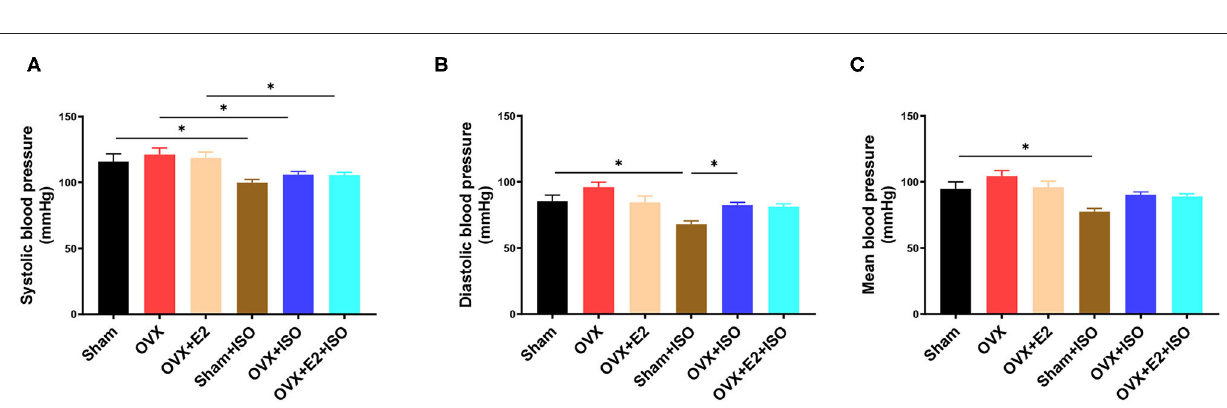
FIGURE 2 | Estrogen decreases blood pressure during catecholamine stress. (A) The systolic blood pressure. (B) The diastolic blood pressure. (C) The mean blood pressure. Results are presented as mean ± SEM. N = 8. * P <